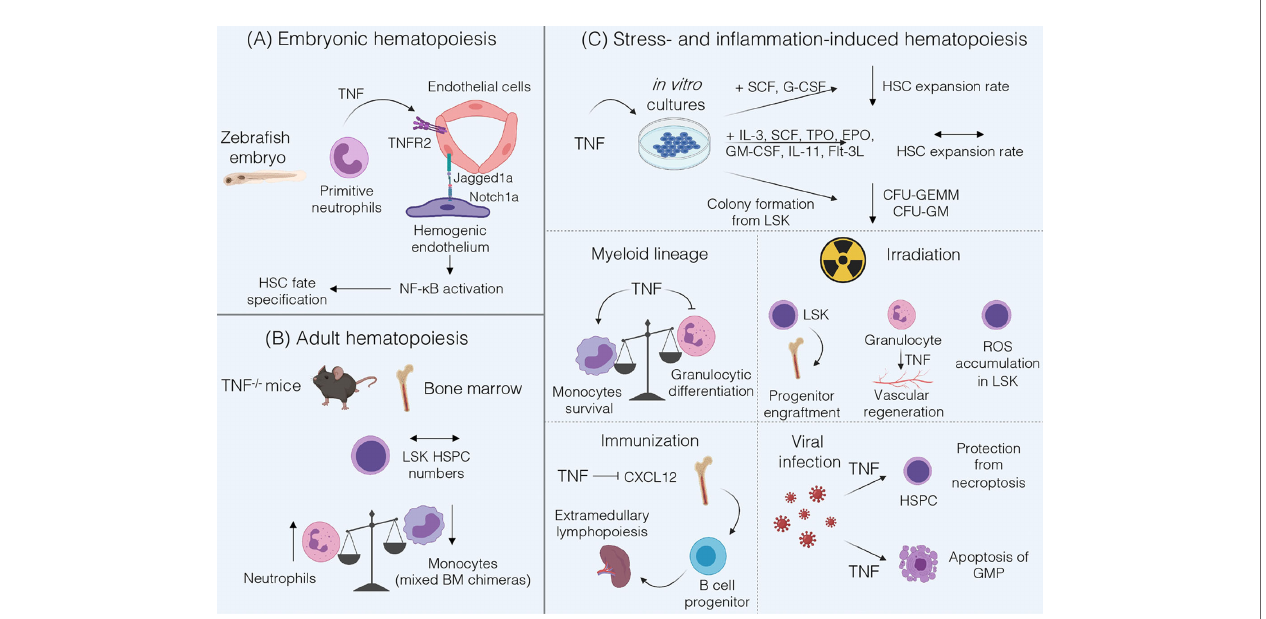
FIGURE 1 | Summary of TNF functions in hematopoiesis. (A) During fetal hematopoiesis in zebra fi sh TNF/TNFR2 signaling is required to establish HSC fate via activation of Notch and NF-kB signaling (18). (B) Bone marrow of adult TNF-de fi cient mice is characterized by normal LSK HSPC numbers and by an increase in Gr-1 + neutrophils (19). Mixed Tnf -/- and Tnf +/+ BM chimeras underrepresent TNF-de fi cient monocytes (20). (C) TNF may inhibit HSC expansion when cultured with SCF and G-CSF, but not in cytokine-rich medium (21). Addition of TNF to LSK cultures inhibits formation of CFU-GEMM and CFU-GM (22). TNF promotes monocytes survival (20) and inhibits proliferation and differentiation of granulocyte progenitors (19, 23, 24). Under in fl ammatory conditions induced by irradiation TNF may be bene fi cial for progenitor engraftment (25) but stromal cell-derived TNF induces ROS accumulation in HSPCs (26), and granulocyte-derived TNF is involved in vascular regeneration (27). Following immunization, TNF may suppress CXCL12-dependent retention of B cell progenitors in the bone marrow leading to their migration (28). In the case of viral infections TNF protects HSPCs from necroptosis, enhances myelopoiesis and induces apoptosis of GMP